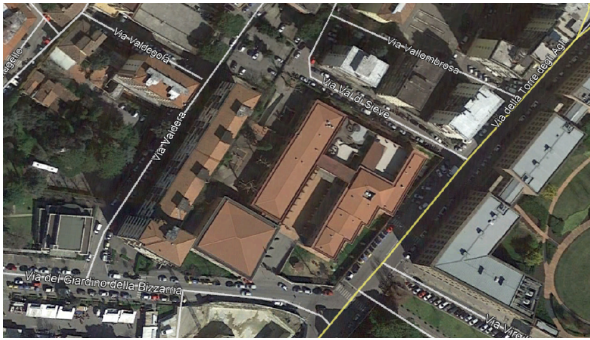
Figure 4: Vamba school. Green highlights the first HUA and pink highlights the second